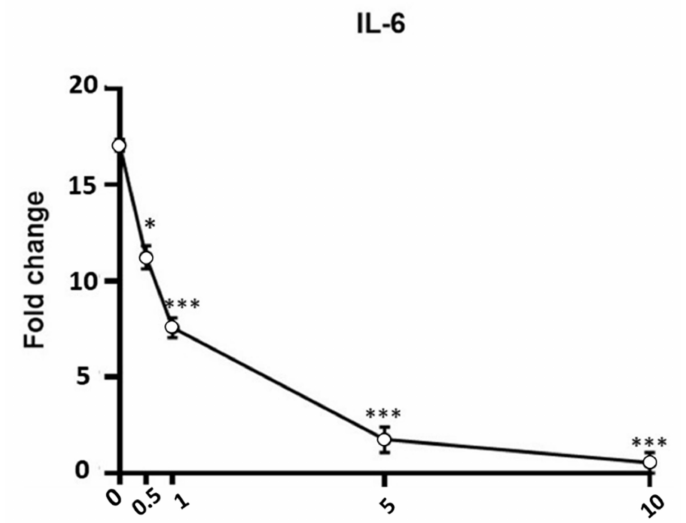
Figure 6. Effect of APEX on IL-6 gene expression in LPS-stimulated cells. U937 cells were prein- cubated (24 h) with increasing concentrations of APEX and then grown for a further 12 h with LPS (1 µ g/mL); the expression level was determined immediately after LPS treatments. Data are expressed as fold increase compared to untreated control cells, and are the means ± SEM of at least three independent experiments. * p < 0.05, *** p < 0.0001, compared to LPS-stimulated cells without APEX (one-way